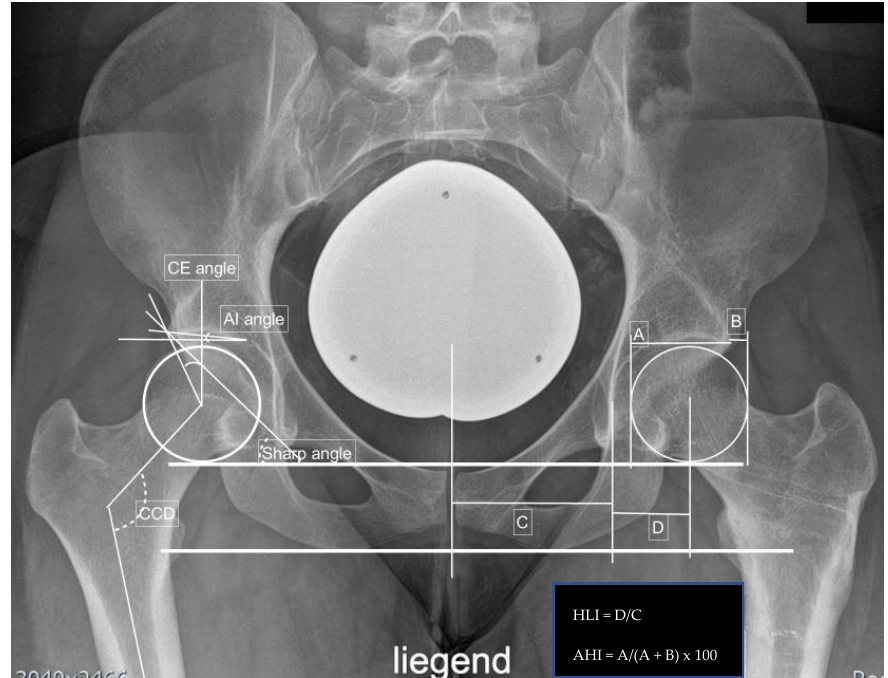
Figure 4. Preoperative measurements in a right-sided borderline dysplastic hip: CE angle 23.4°, AIA 4.9°, sharp angle 40.0°, hip lateralization 0.51, anterior hip index 82.8, and CCD angle 121.0°. During follow-up, the functional outcome was classified into (1) very satisfied, (2) sat- isfied, (3) neither satisfied nor dissatisfied, and (4) dissatisfied. The complications were defined as either perioperative, such as bleeding that required blood transfusion, or